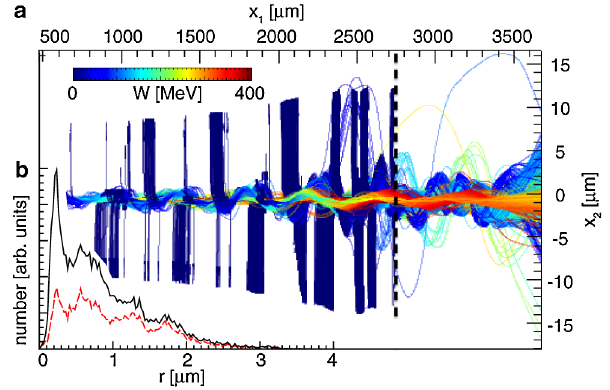
FIG. 5. (a) Electron trajectories obtained from the modeling. (b) Histogram of the betatron amplitudes for entire 3.7 mm jet (solid black) and for the last 1 mm (dashed